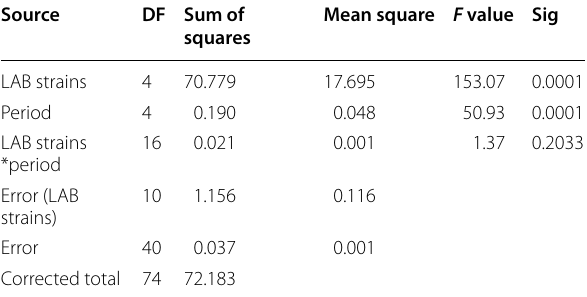
Table 4 ANOVA table of repeated measurement describes the effect of LAB strains, period and the interaction of LAB strains with period on means of encapsulation efficiency of